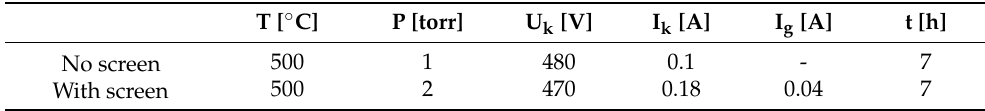
Table 2. Working parameters of the nitriding process.